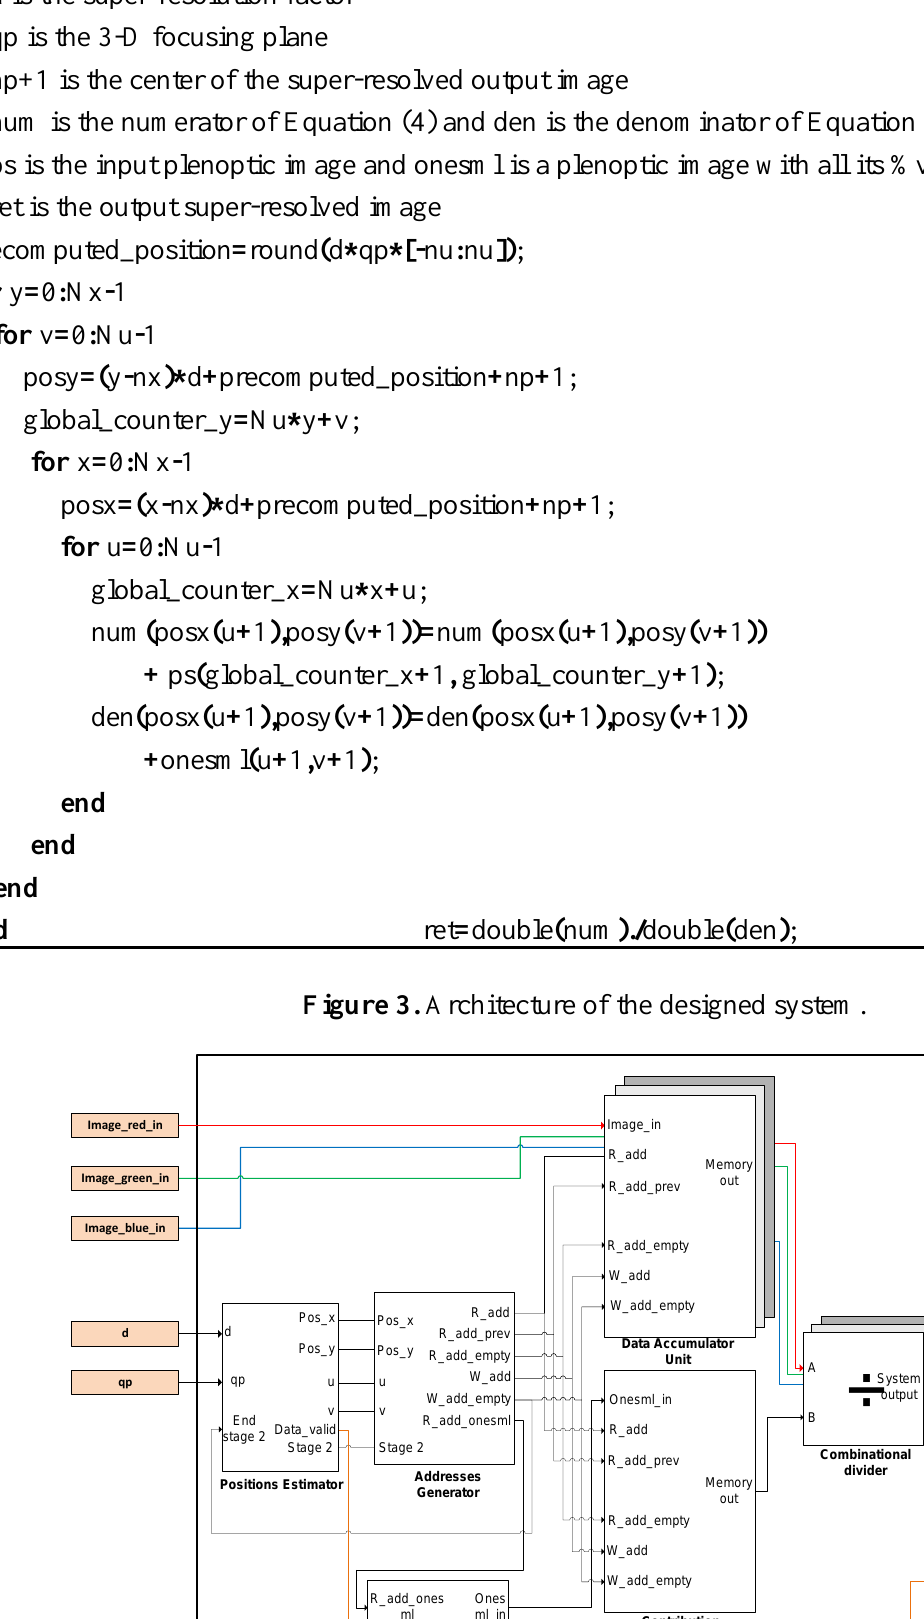
Algorithm 3 Matlab-code for the algorithm for hardware implementation %d is the super-resolution factor